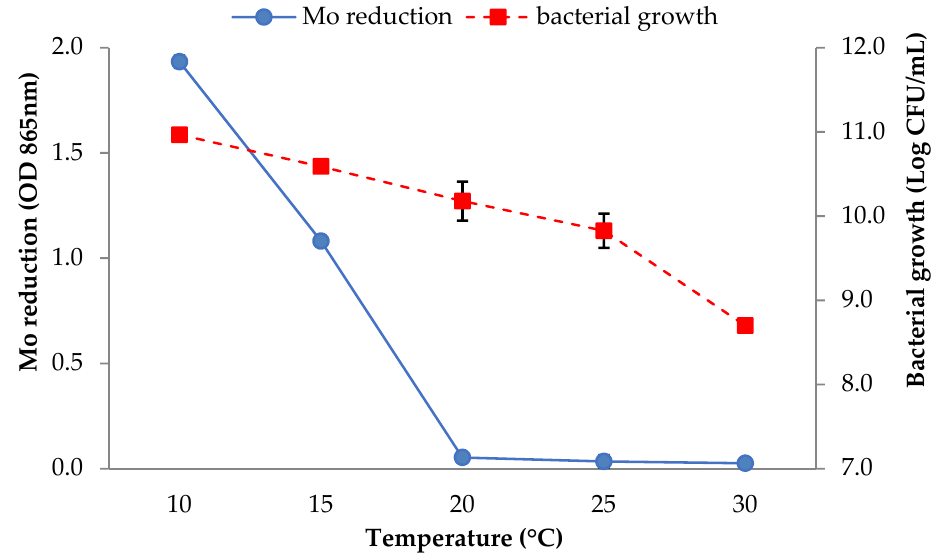
Figure 7. The effects of temperature on Mo reduction and growth of strain AQ5-05. The error bars represent the mean ± standard deviation for three replicates.